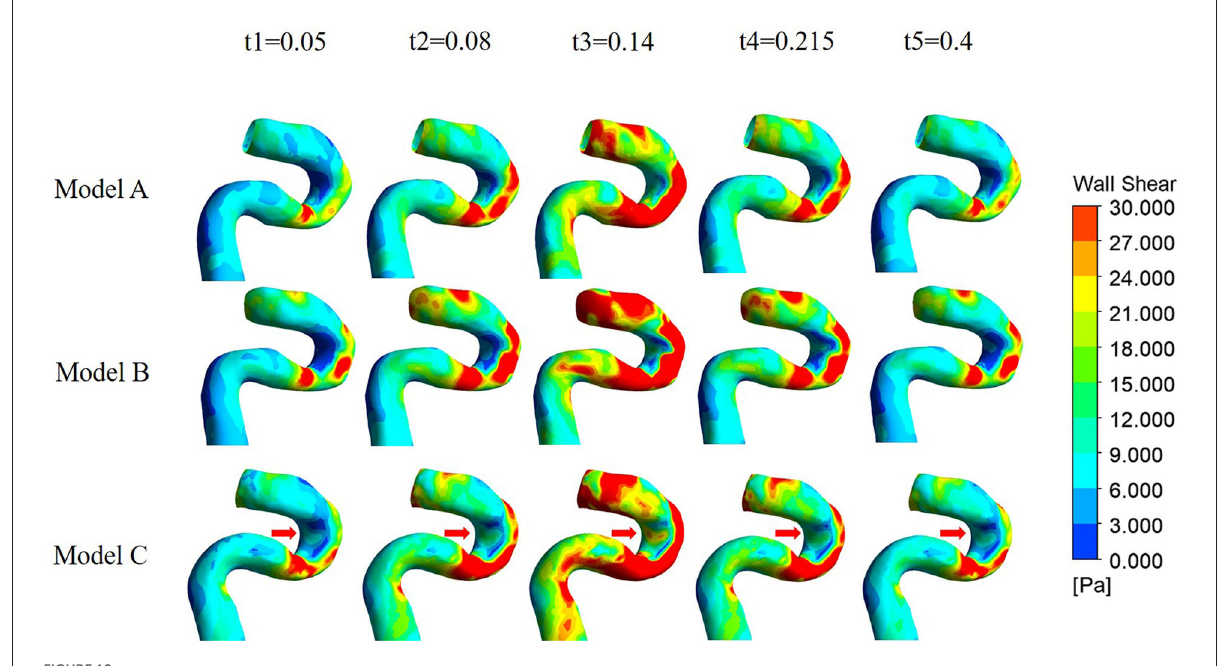
FIGURE12 Contours of WSS of the three models at the carotid siphon.